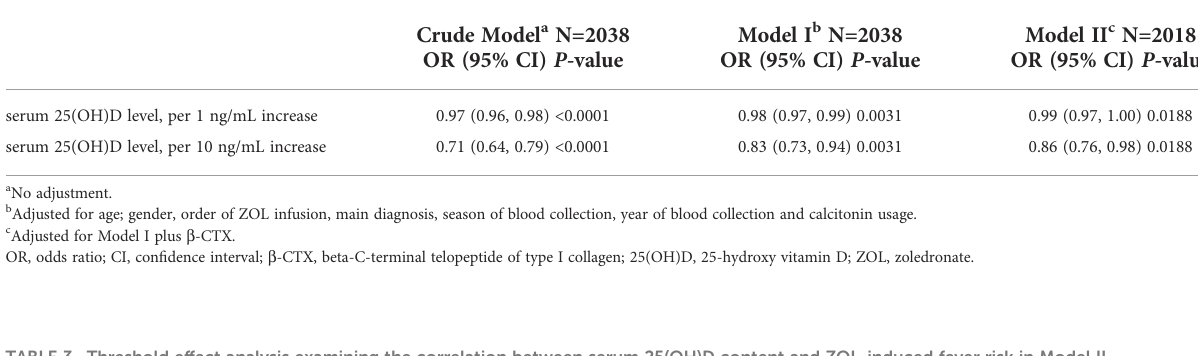
TABLE 3 Threshold effect analysis examining the correlation between serum 25(OH)D content and ZOL-induced fever risk in Model